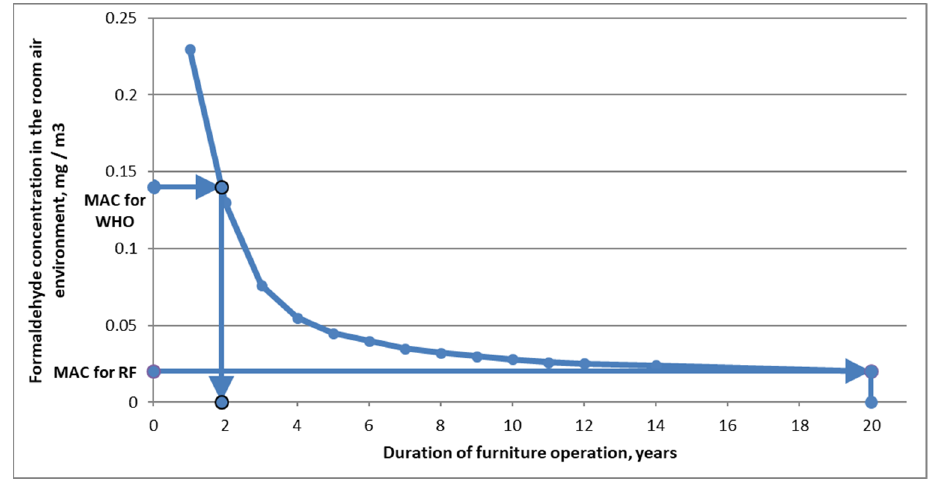
Figure 1. Kinetics of formaldehyde concentration in the indoor air environment during the operation of furniture.